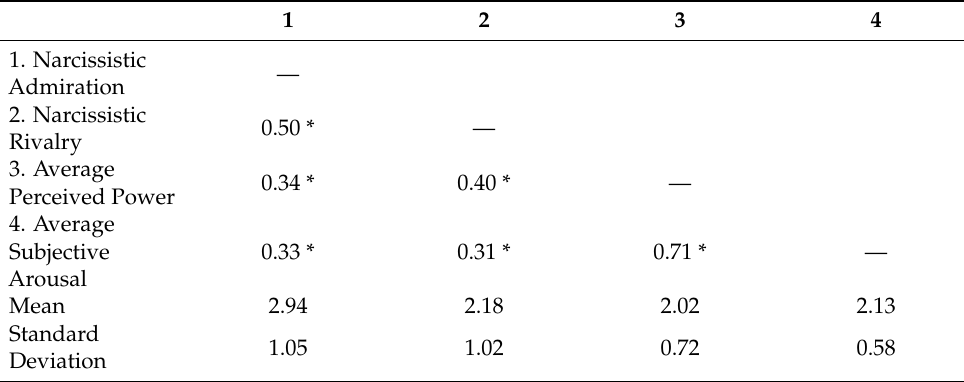
Table 1. Intercorrelations and descriptive